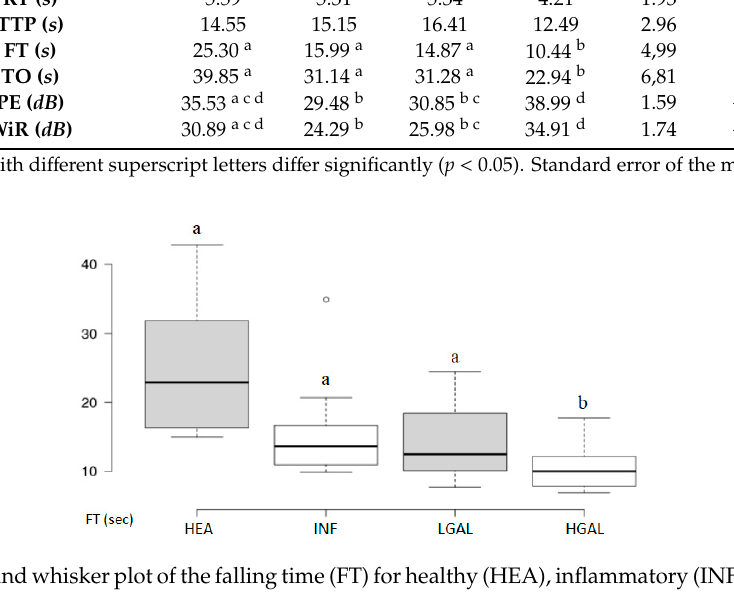
Figure 7. Box and whisker plot of the falling time (FT) for healthy (HEA), inflammatory (INF), low-grade alimentary lymphoma (LGAL) and high-grade alimentary lymphoma (HGAL). a,b Values with di ff erent superscript letters di ff er significantly ( p <